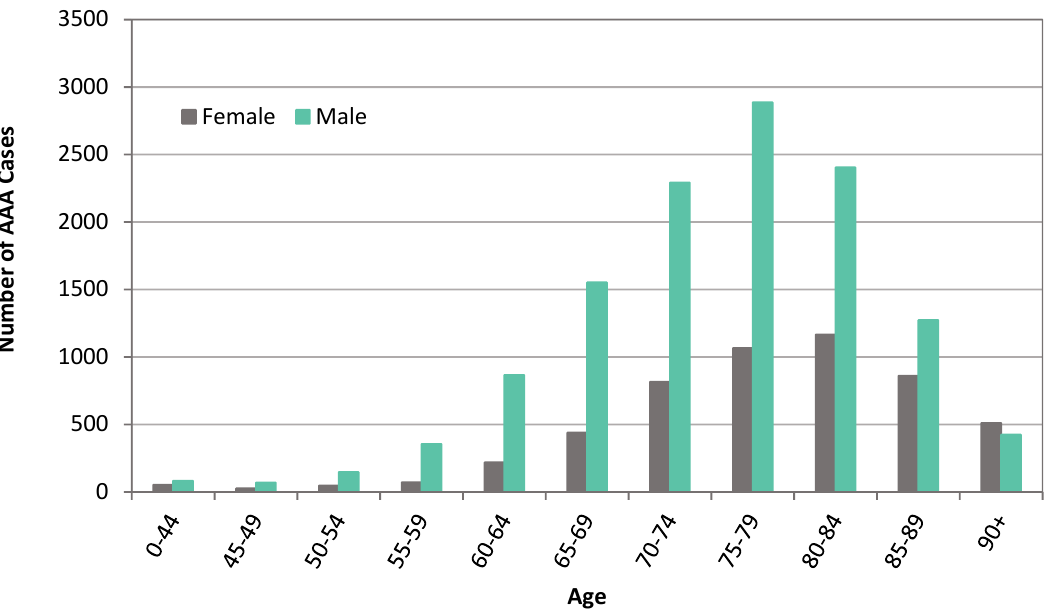
Figure 1. AAA prevalence grouped by age and sex, 2001–2018.